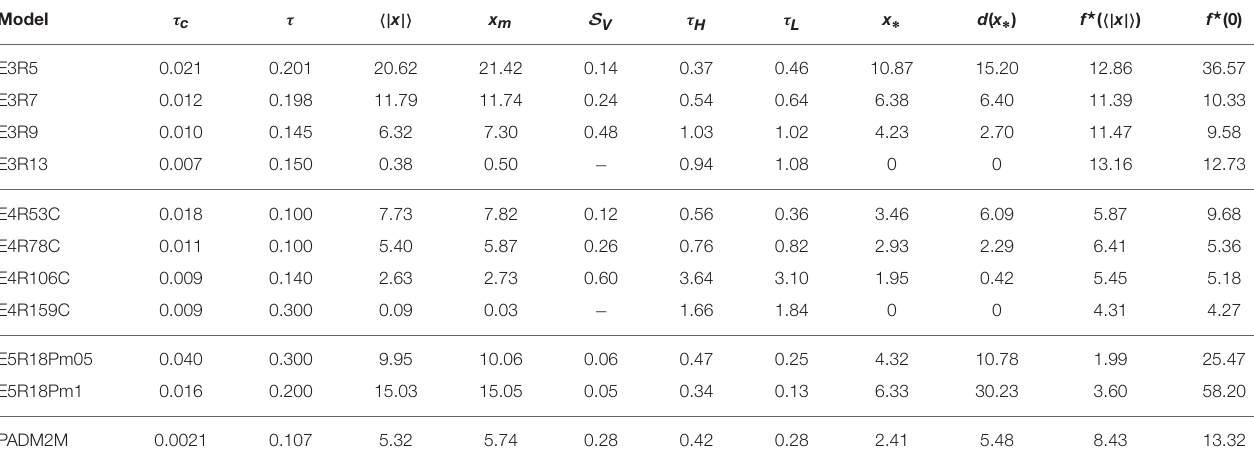
TABLE 2 | Characteristic properties of the stochastic model for all the cases explored.